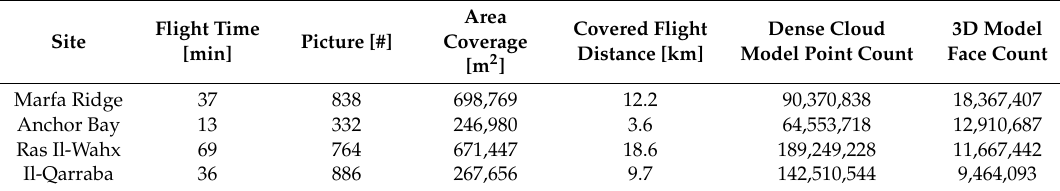
Table 3. Information on flights performed in the study